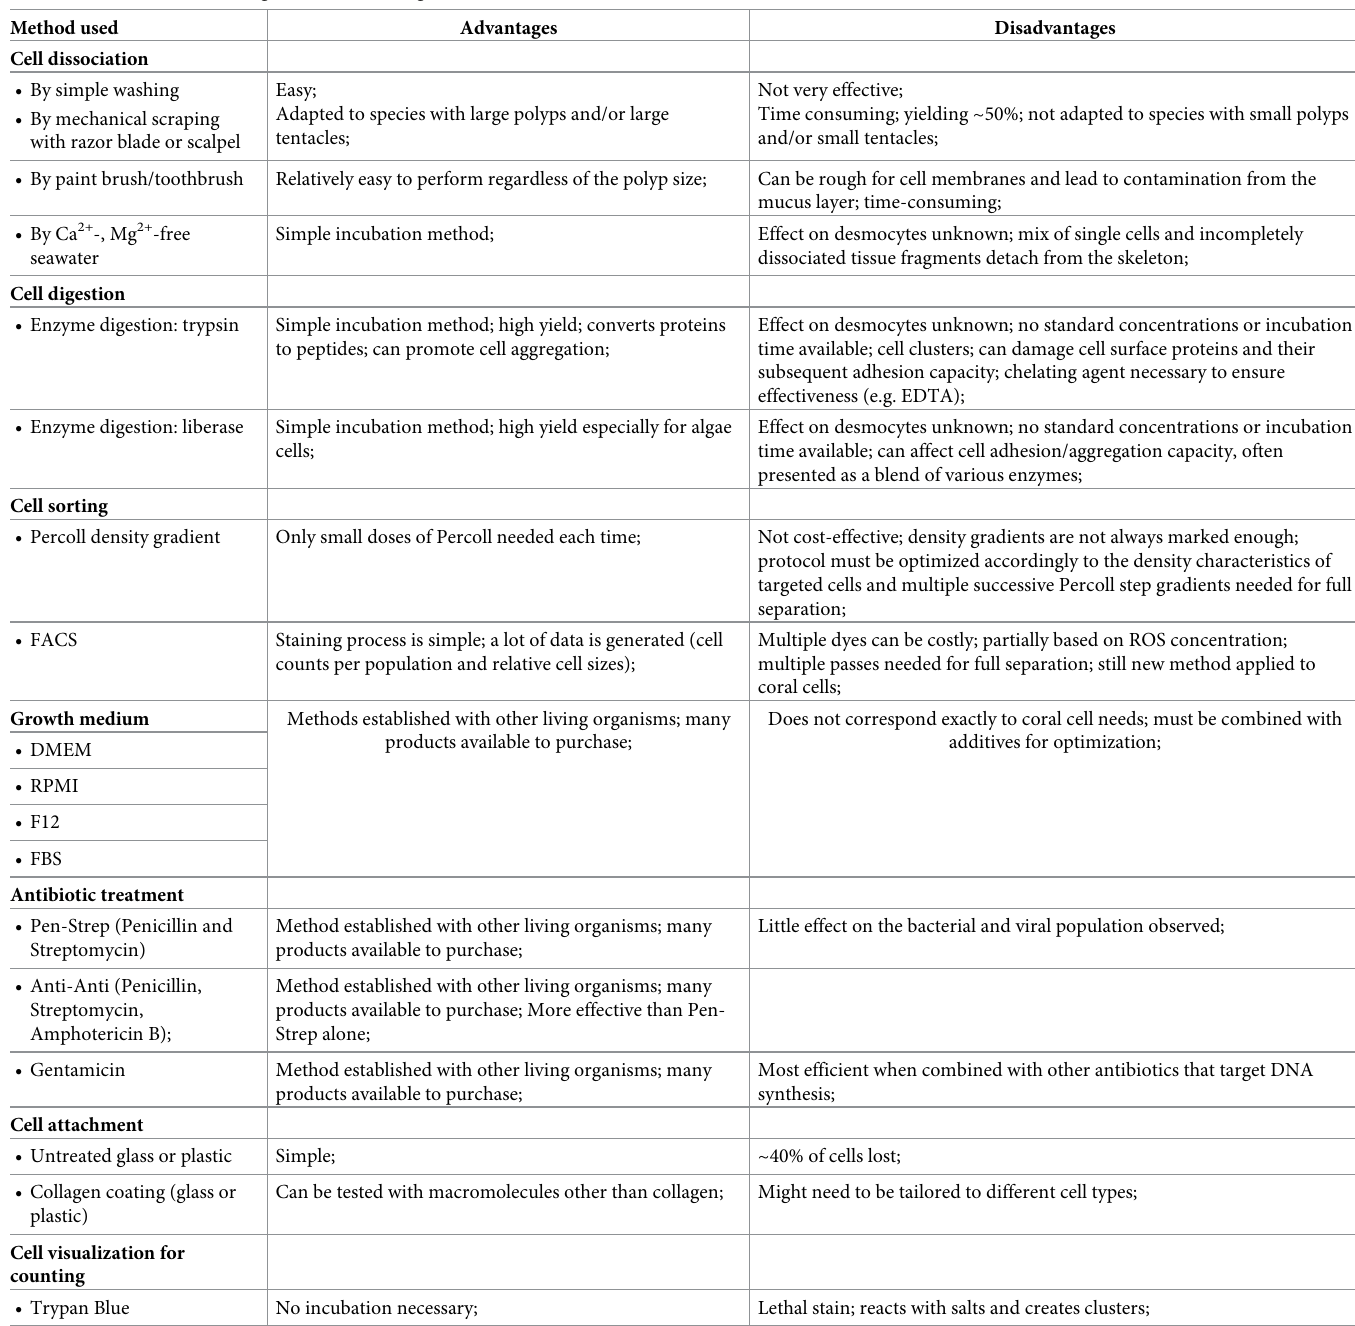
Table 2. Summarized advantages and disadvantages of each method tested for coral cell culture. Method used